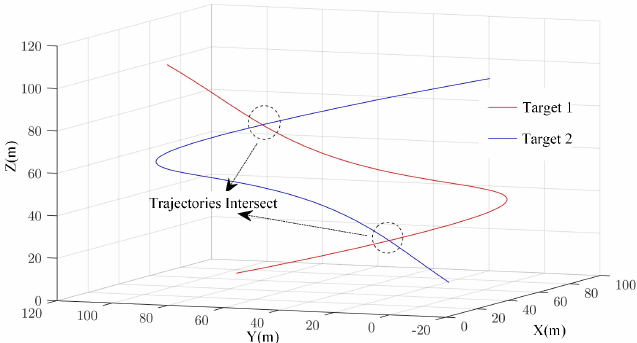
Figure 4. Trajectories of targets in the dense